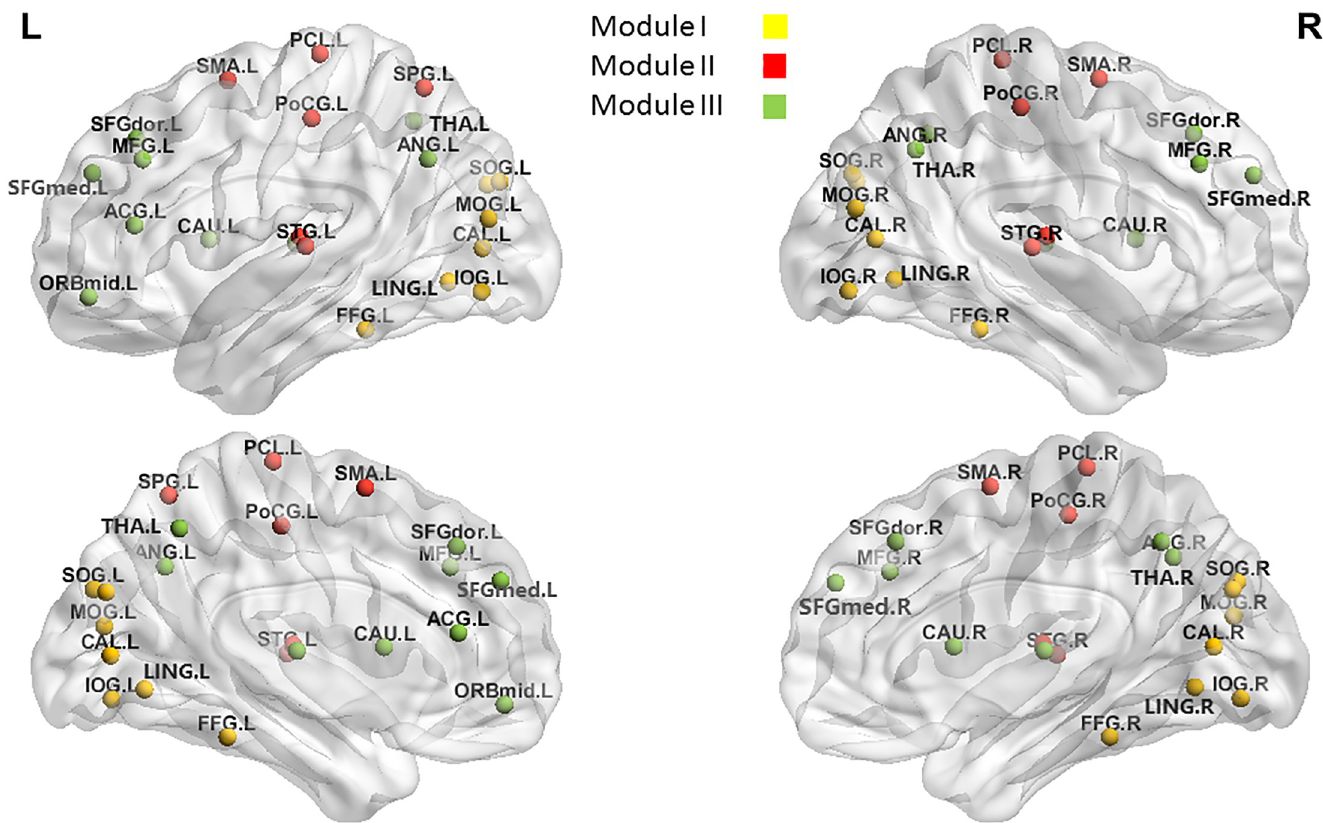
Fig 1. Visualization of the four modules selected for network efficiency analyses. Modules I, II, and III mean the sets of brain areas involved in visual processing, sensorimotor functions, and the DMN, respectively. L: left hemisphere; R: right hemisphere.